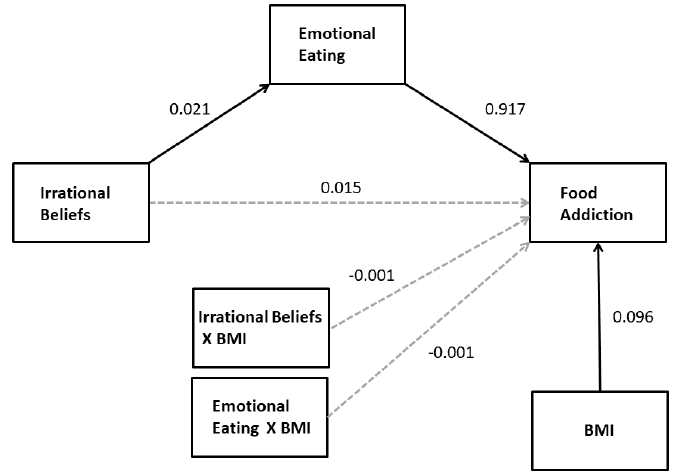
Figure 2. The statistical model for the moderated mediation of the effect of irrational beliefs on FA with BMI as moderator. Solid arrows indicate statistically significant regression coefficients. Nonsignificant mediator variables and BMI effects on mediators are not shown for simplicity.